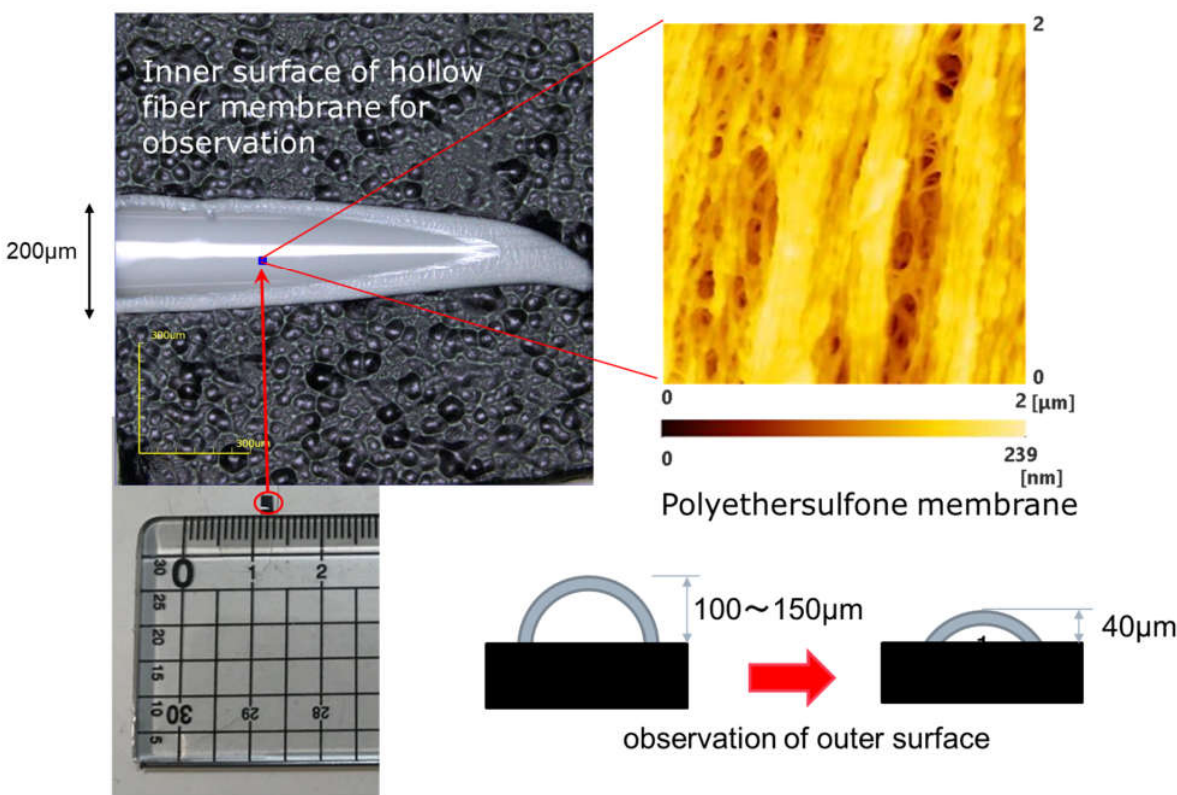
Figure 1. Inner surface of hollow fiber membrane used for observation (LEXT OLS4000, 3D measurement laser microscope, Olympus Co., Ltd., Tokyo, Japan) [15,16].